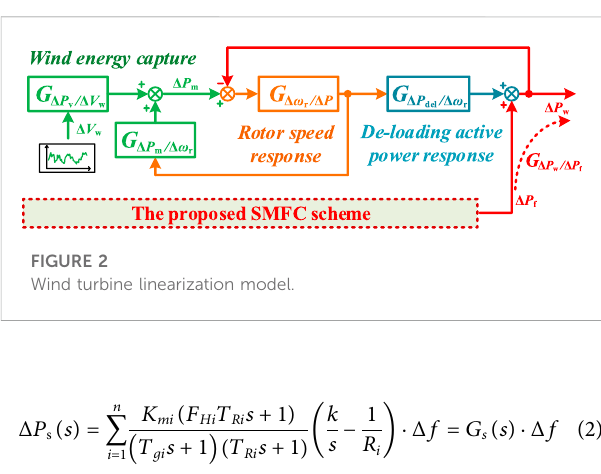
FIGURE 2 Wind turbine linearization